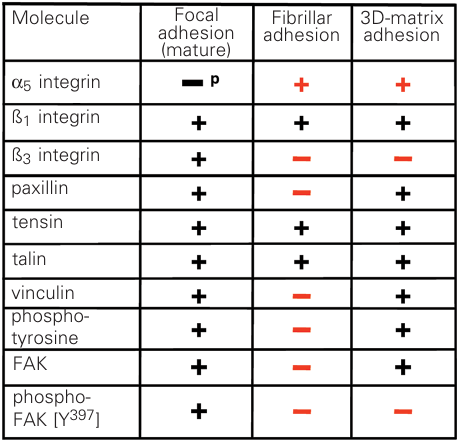
1. Molecular compositions of three types of cell adhesions.